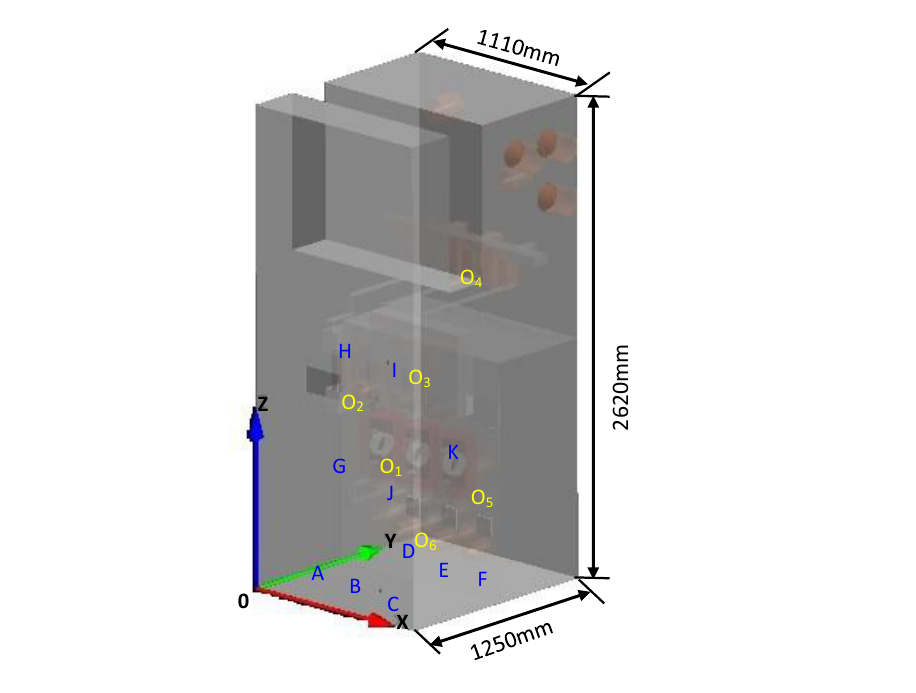
Figure 10. FDTD switchgear simulation model.